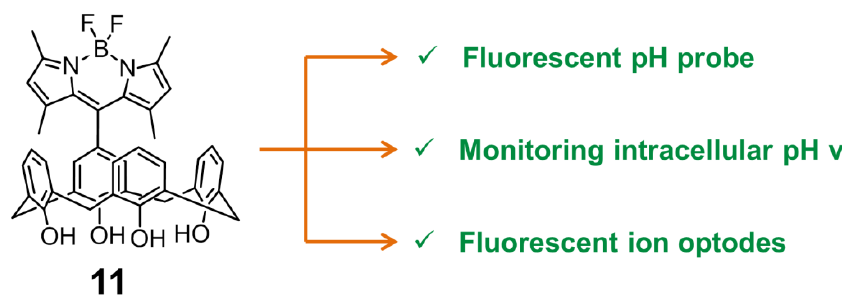
Figure 10. Chemical structures of mono-BODIPY functionalized calix[4]arene 11 .